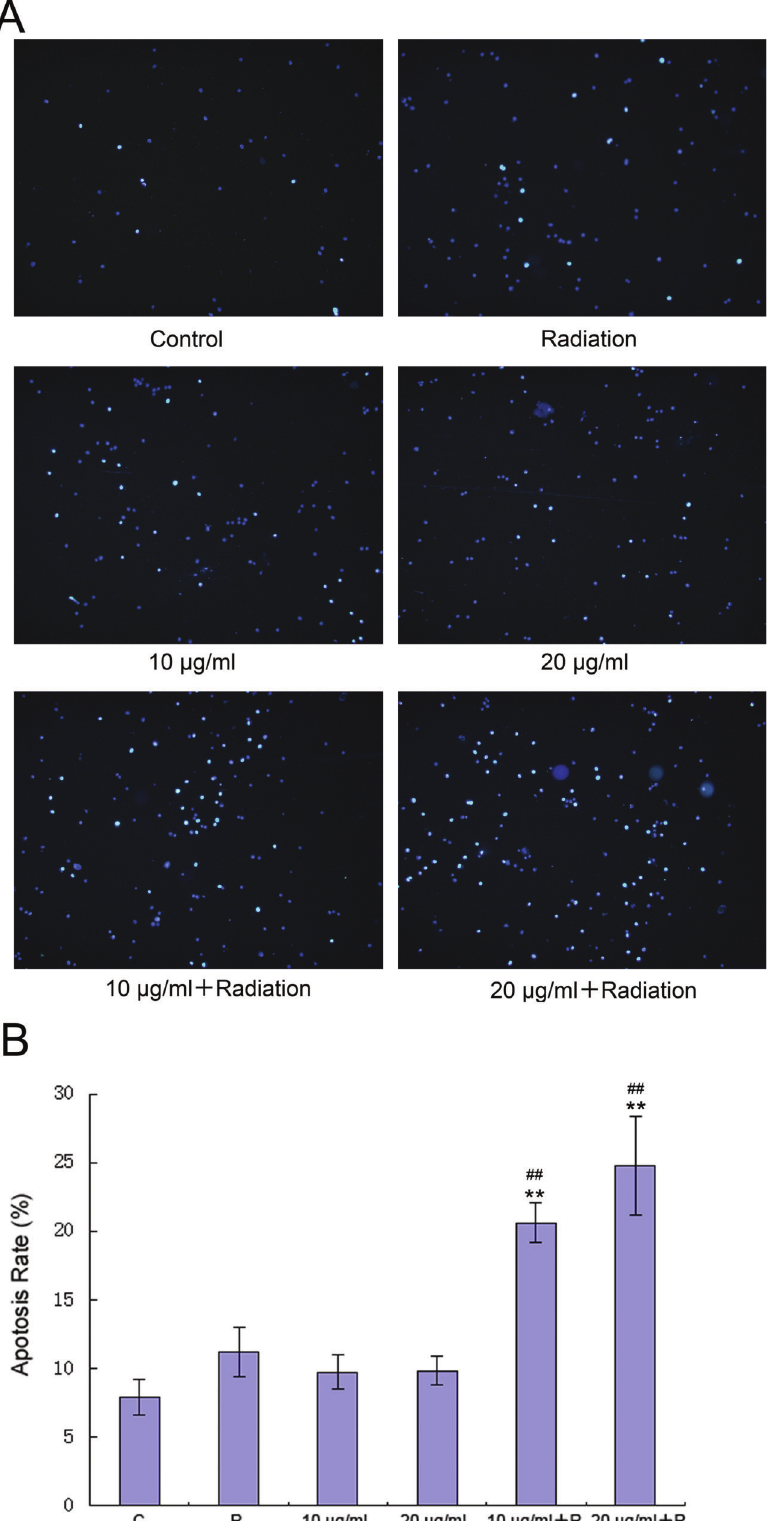
Figure 2 - Elemene induces apoptosis in A549 cells. Cells were incubated with 10 or 20 m g/mL elemene for 24 h, followed by irradiation with 4 Gy X-rays and washing with PBS. (A) Cells were imaged with an Olympus BX-51 fluorescent microscope using appropriate filter cubes. (B) Chromatin condensation was analyzed by fluorescence microscopy after DNA staining with Hoechst 3334. The results are expressed as the mean ± SD of three independent experiments, n=3, ** p o 0.01 compared to control, ## p o 0.01 compared to radiation alone.